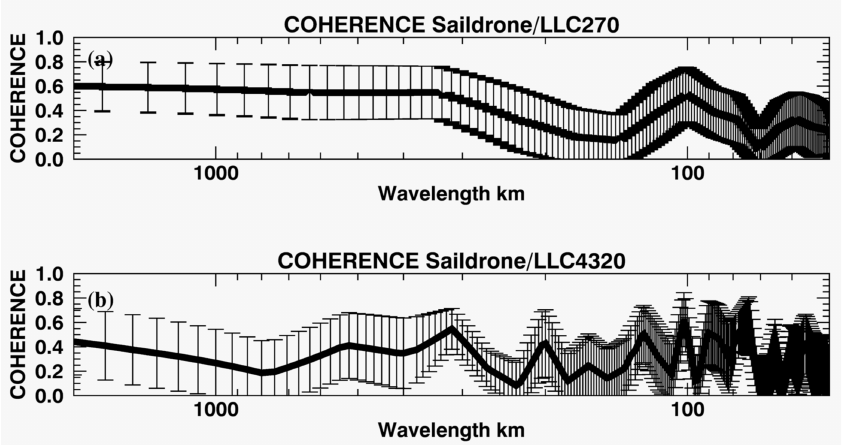
Figure 8. ( a ) Coherence for LLC270/Saildrone and ( b ) coherence for